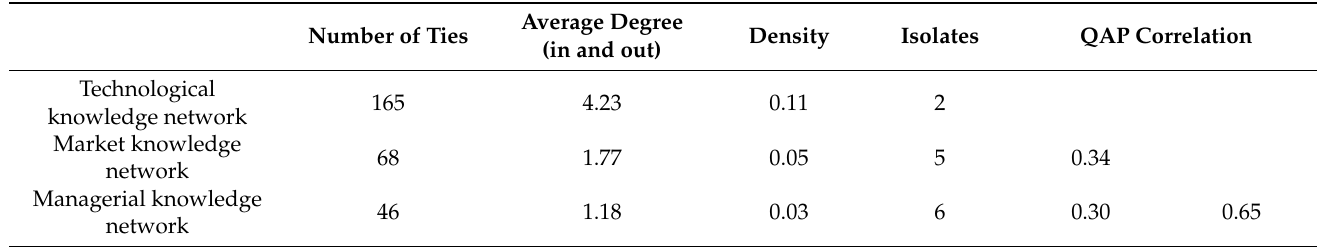
Table 3. Network